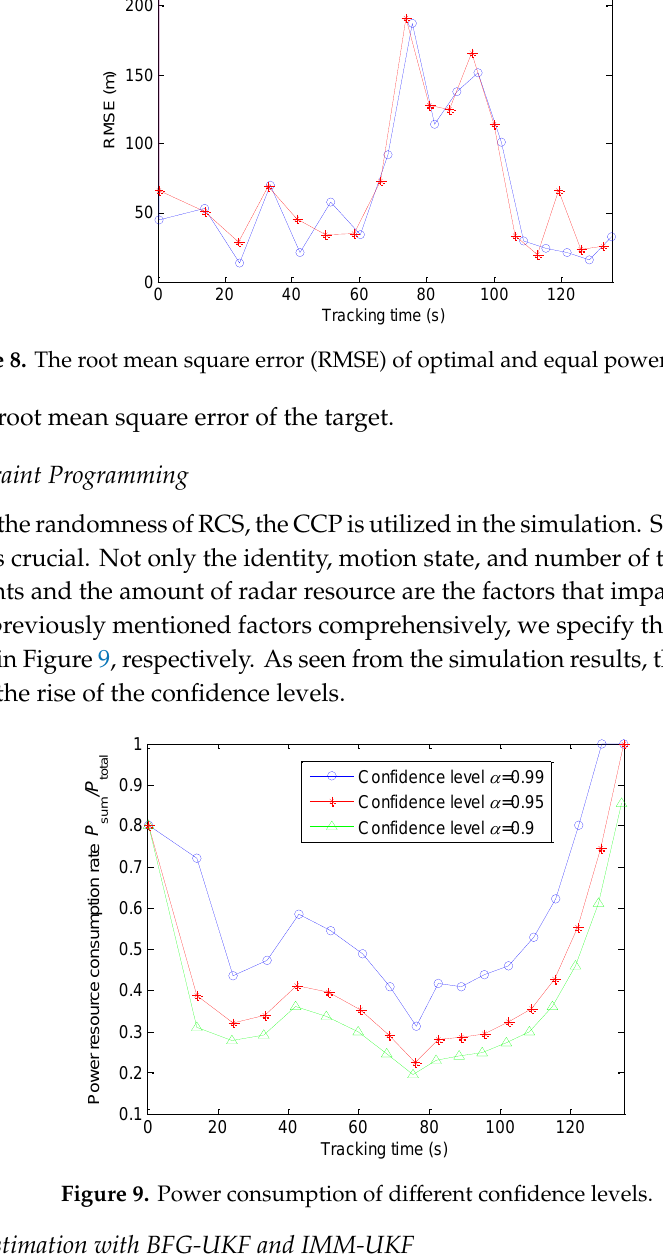
Figure 9. Power consumption of different confidence levels.